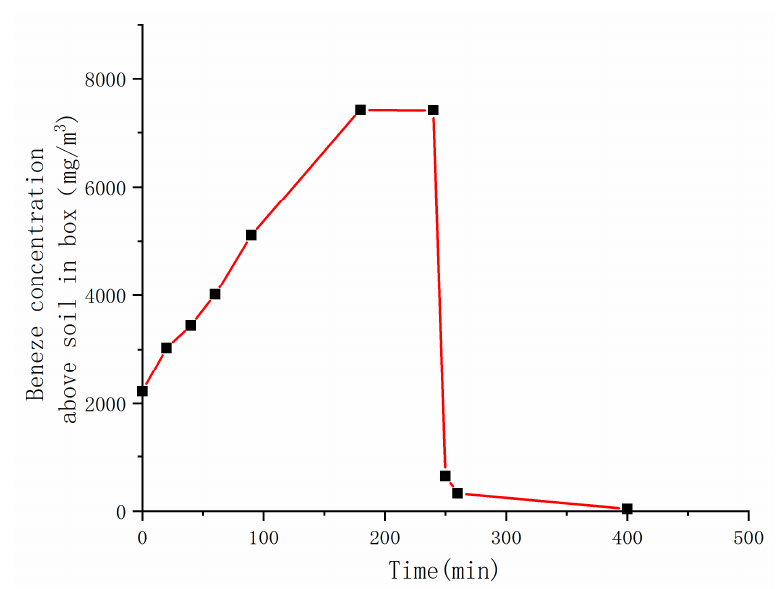
Figure 4. The benzene concentration above the soil in the box over time. After the soil was filled, the benzene concentration in the soil gas was uniform, 1000 mg · m − 3 . At the beginning of the heating stage, the benzene concentration Before treatment, after repeated mixing, the soil moisture was almost uniform, which was 36%. After 24 h heating and 20 h extraction, the soil was divided into three layers (depth 5, 20, 35 cm), and the humidity was detected according to the soil sampling posi ‐ tion. After treatment, the average humidity of the soil at the depths of 5, 20 and 35 cm was 20.28%, 29.84%, 32.56%, respectively, the overall average humidity was 29.39%. The treat ‐ ment process took away 6.61% of the soil moisture, which was 14.54 kg. The contour map of humidity was drawn with the left front end of the device as the origin, and the result was shown in Figure 5. The soil moisture after treatment was low in the surface layer, high in the bottom layer, low in the middle, and high around.